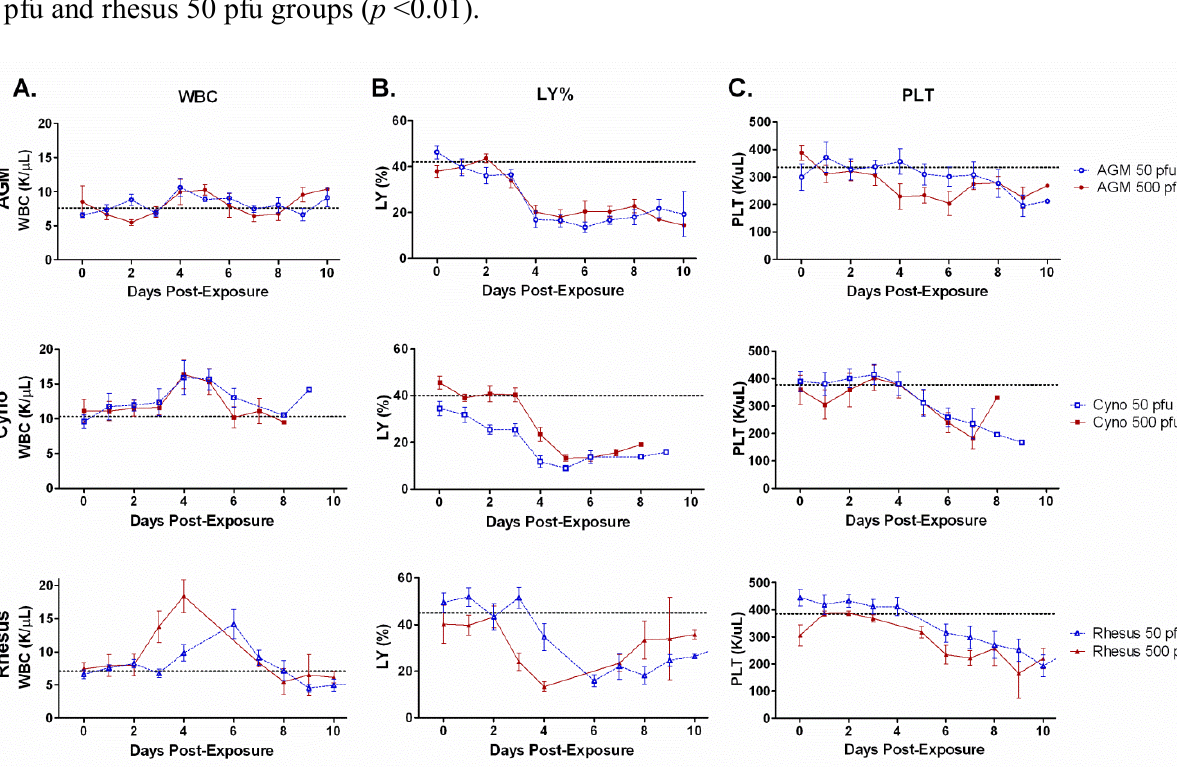
Figure 3. Average white blood cell count (WBC), percentage of lymphocytes and platelet number. Graphs are shown for the group averages of A ) WBC, B ) lymphocytes, C ) platelets in three NHP species after exposure to two different doses of aerosolized SUDV. Average measurements on day 0 were taken before exposure serve as a baseline. There were six animals per group. Error bars represent the standard error of the mean. The horizontal dashed line indicates the average baseline (day 0) for the 12 animals in both dosage groups. WBC increased significantly above baseline for cynos and rhesus ( p <0.05). All groups had significant decrease in lymphocytes late in infection ( p <0.01) except the rhesus 500 pfu group ( p >0.05). Platelets decreases were significant for cyno, AGM 500 pfu and rhesus 50 pfu groups ( p